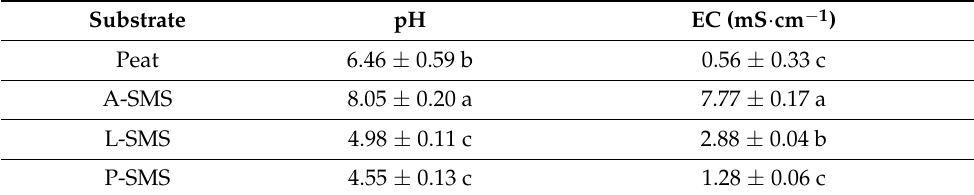
Table 5. The pH and EC value of 100% SMSs and 100% peat used in the study (mean ± SD). Substrate